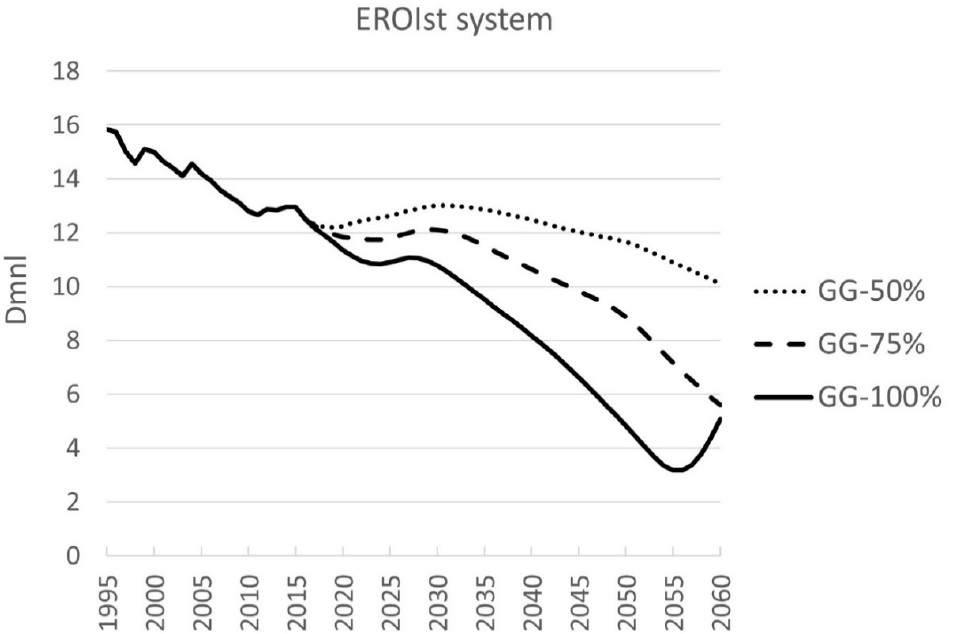
Figure 4. Estimated EROI for the global society from 1995 to 2015, and predictions into the future with and without massive switching of fossil fuels to renewables (from 50 to 100 percent “Green Growth” renewables by 2050). Y-axis is the return to one unit invested. Source: Capellan Perez et al., 2018 [38].